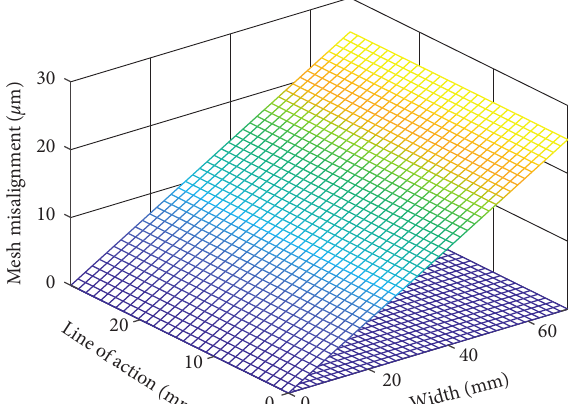
Figure 2: Mesh misalignment model for a helical gear pair.